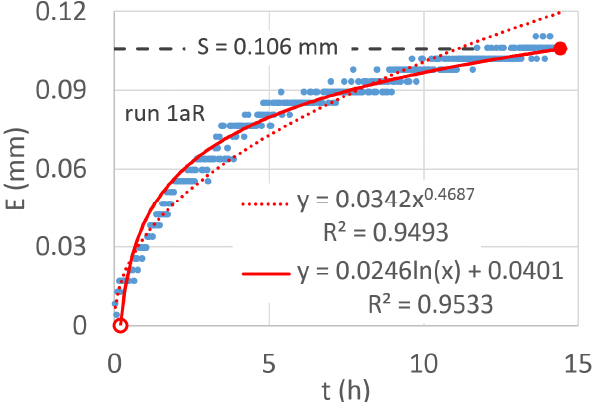
Figure 4. For runs #1aR, temporal variation of the evaporation depth and the corresponding fitted power-law and semi-log relationship. The t 0 (red circle) and t max (red dot) values are also indicated.